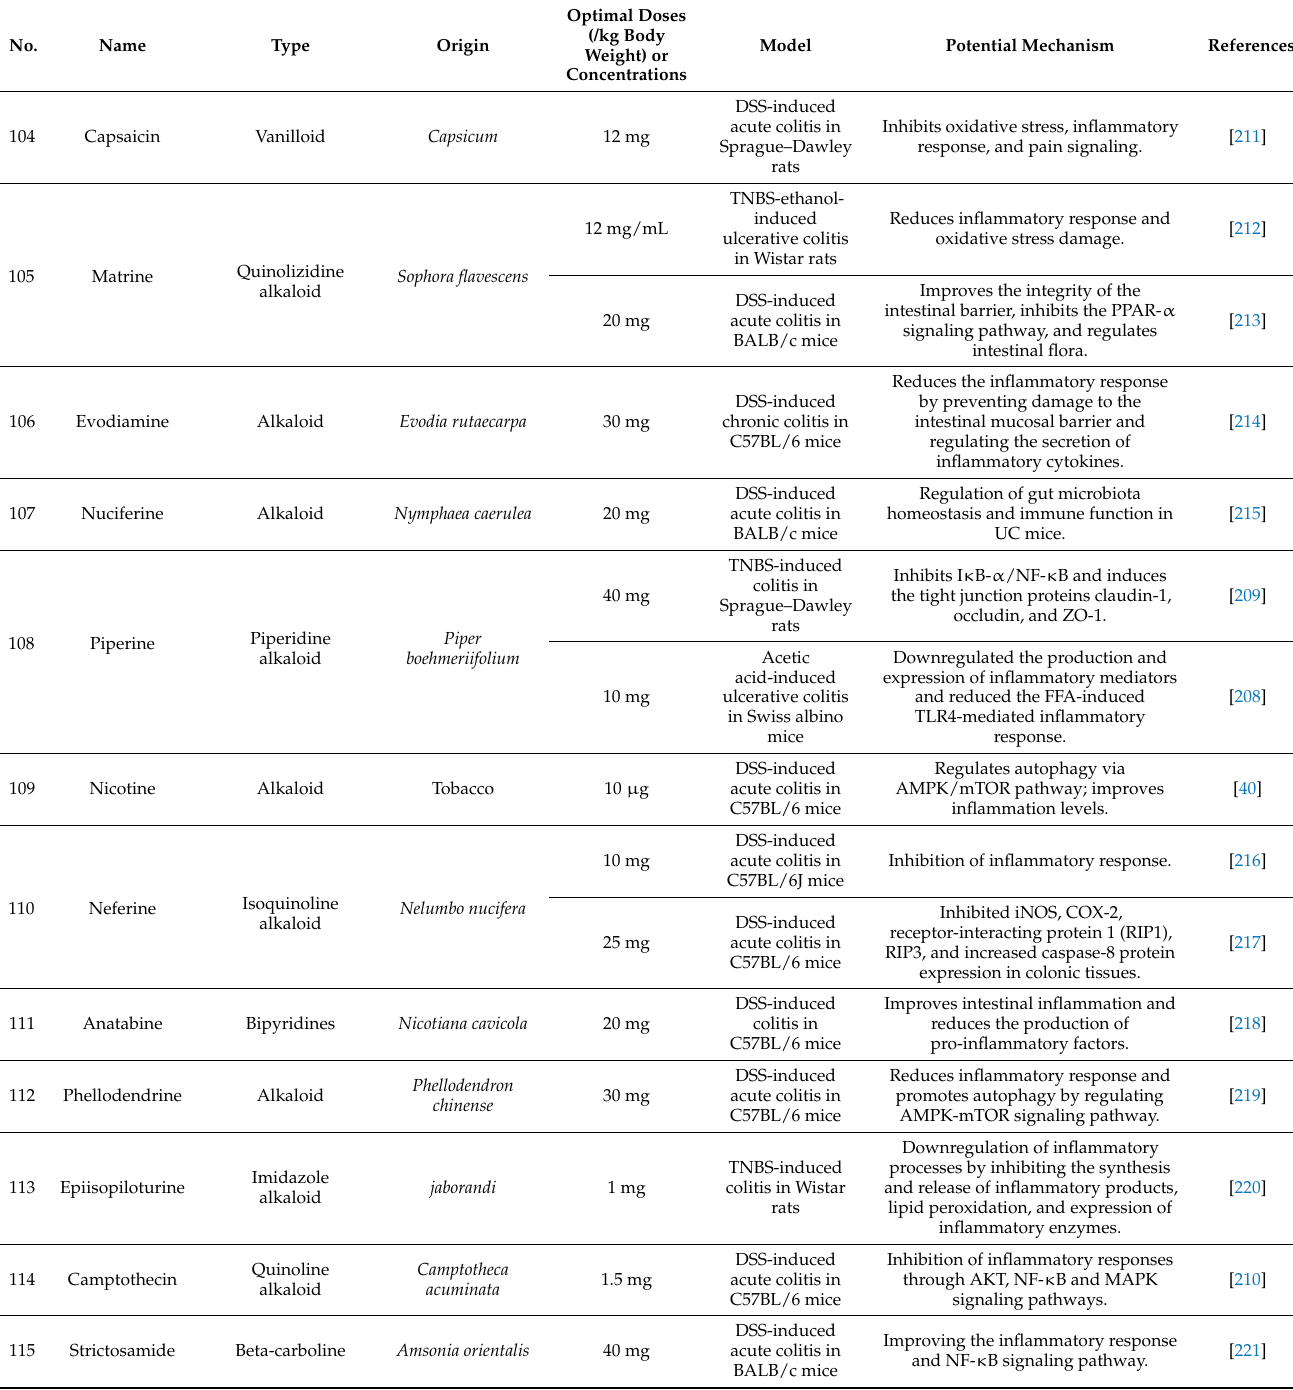
Table 6. In vivo therapeutic effects of alkaloids on experimental